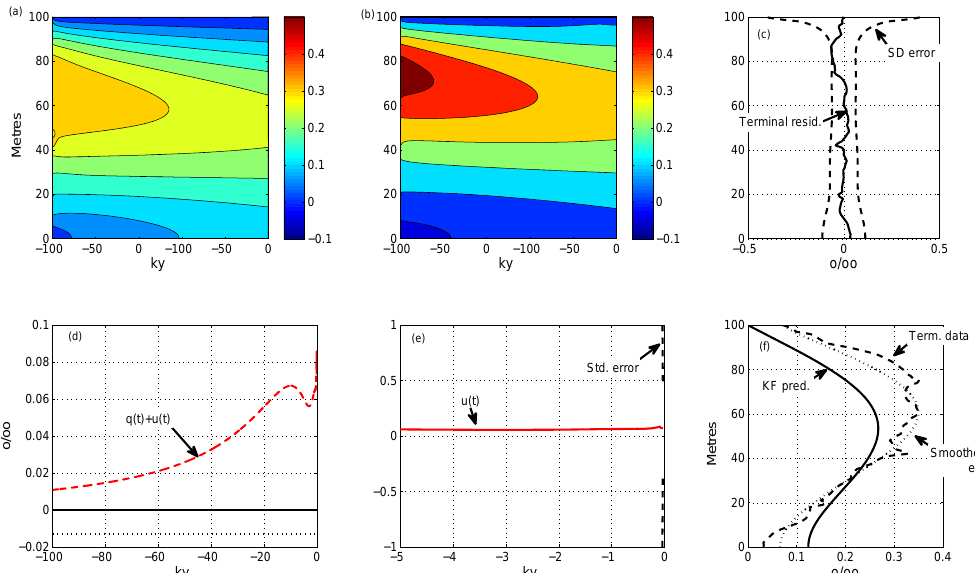
Figure 7. Purely diffusive solution for the mean core, to 100m depth, with k linearly increasing from 5 × 10 − 11 to 10 − 10 m 2 s − 1 ; w = 0 . The prior boundary condition is C h ( t ) = 0 and the initial condition is the same as the terminal data, with larger uncertainties. Final values are all within 1 standard deviation of the estimated error bar. Apart from a small increase in u (correction to C h ( t ) with time), the system reproduces the terminal constraint largely by adjusting the initial conditions. (a) Kalman filter (KF) solution from initial conditions and no control adjustment. (b) Final smoothed estimate over 100ky. (c) Residual (solid line) at the terminal time between the estimate and the terminal data, and the 1 standard deviation uncertainty limits. (d) The total control q ( t ) + e u ( t ) (dashed) and prior q ( t ) (solid) as well as the estimated maximum and minimum of LGM δ 18 O w . (e) u ( t ), only for the last 5ky and showing the sharp drop in its uncertainty near the terminal time. Standard errors lie off-scale except at the very end. (f) KF prediction of the terminal data (same as a conventional forward calculation from the initial conditions and a priori C h ( t ), solid line), the terminal data (dash–dot), and the RTS fit to the